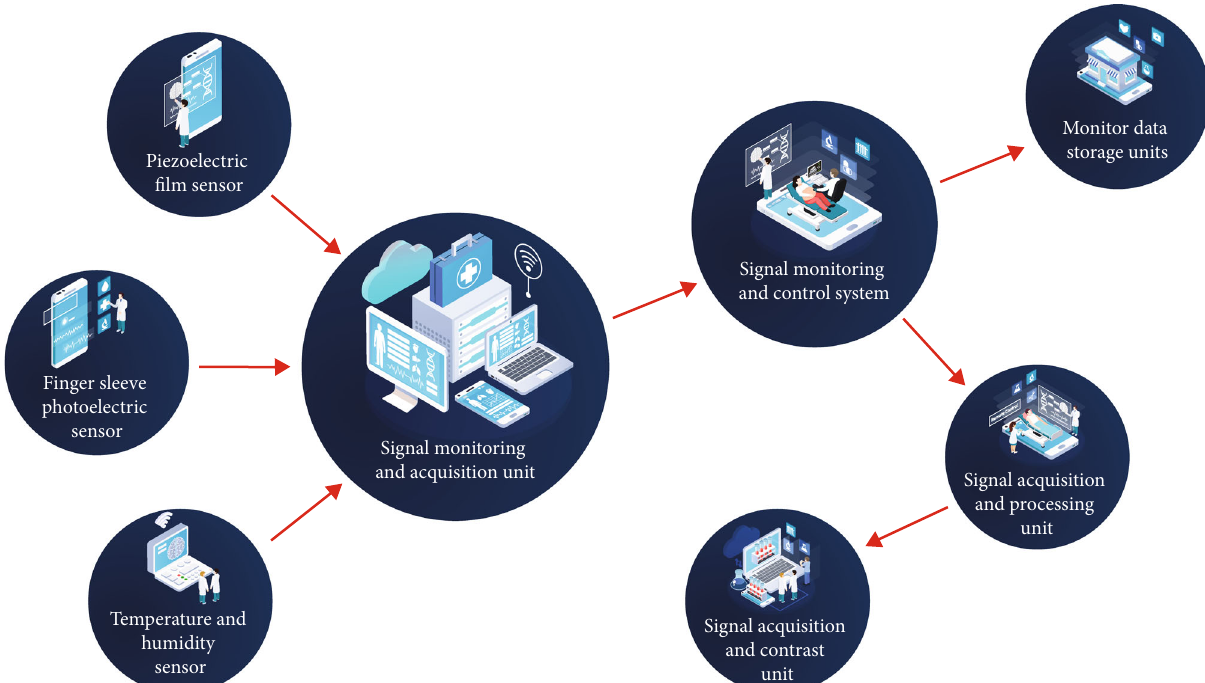
Figure 1: A manufacturing method of physical training monitoring